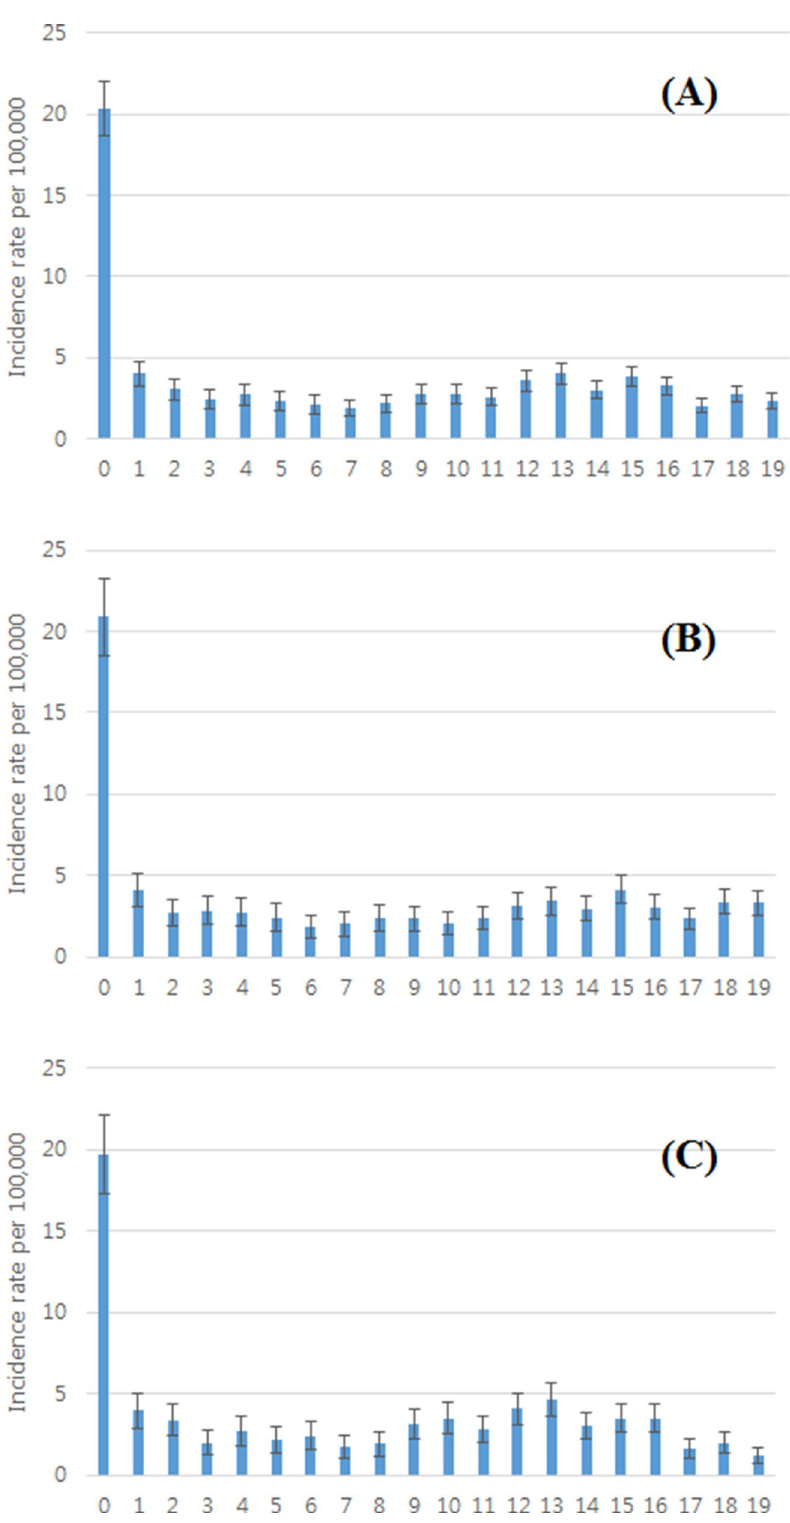
Figure 3. Sex-specific incidence rate of congenital scoliosis based on age (0–19 years), from 2011 to 2015: ( A ) Overall (female + males), ( B ) Males, and ( C ) Females. X-axis; age in years, Y-axis; incidence rate per 100,000. 95% confidence intervals are also